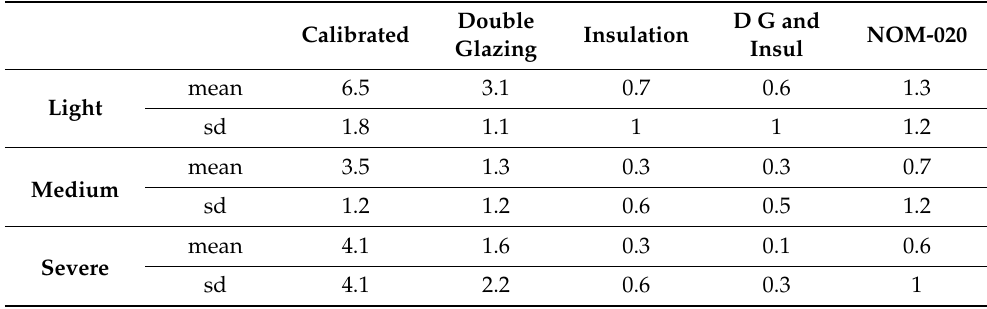
Table 10. Average days per month with light, medium and severe underheating. D G stands for double